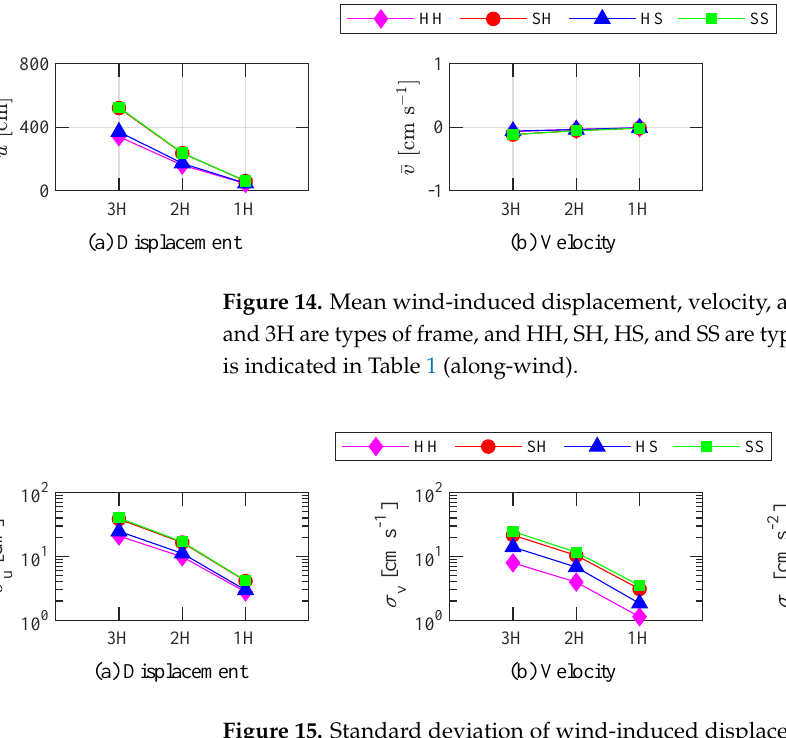
Figure 15. Standard deviation of wind-induced displacement, velocity, and acceleration of the FD system. 1H, 2H, and 3H are types of frame, and HH, SH, HS, and SS are types of added components of systems, which is indicated in Table 1 (along-wind).